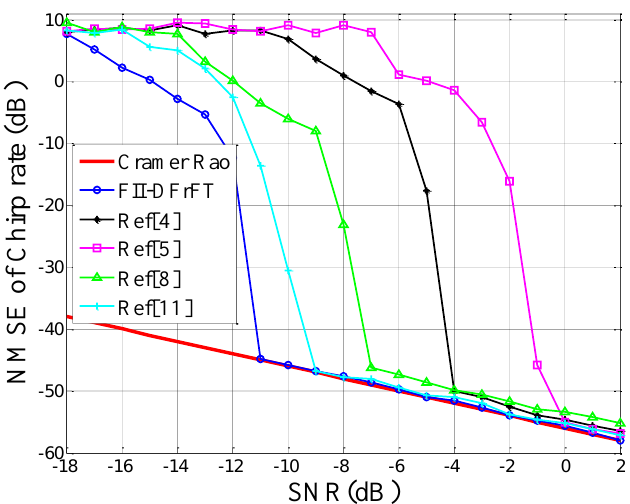
Figure 1. Normalized Mean Squared Error (NMSE) of µ 0 for signal Ω 1 versus the signal-to-noise ratio. FII, Fast Iterative Interpolated.